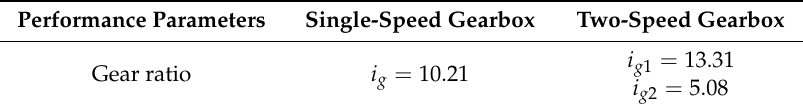
Table 5. Performance parameters of the one-speed and two-speed gearbox.